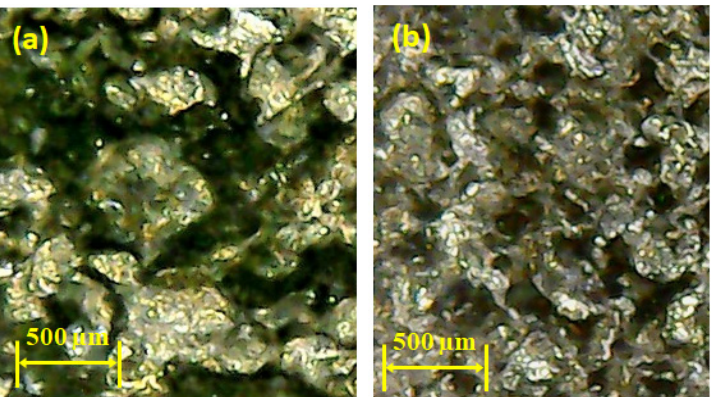
Figure 11. Micrographs representing the effect of polarity on MRR. ( a ) Eroded surface at negative polarity. ( b ) Eroded surface at positive polarity.